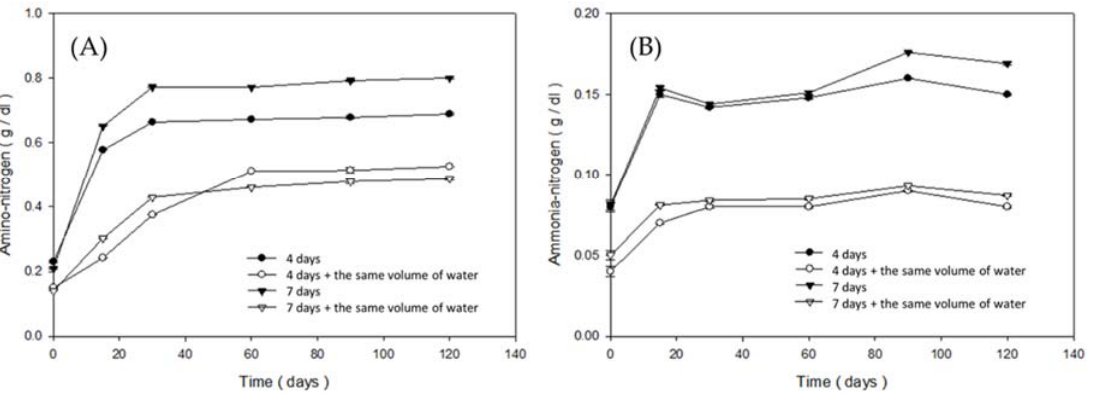
Figure 4. Changes in ( A ) amino nitrogen during the brewing period of fish sauce of each group; ( B ) ammonia nitrogen during the brewing period of fish sauce of each group (— ● —: Group A; — ○ —: Group B; — ▼ —: Group C; — △ —: Group D).